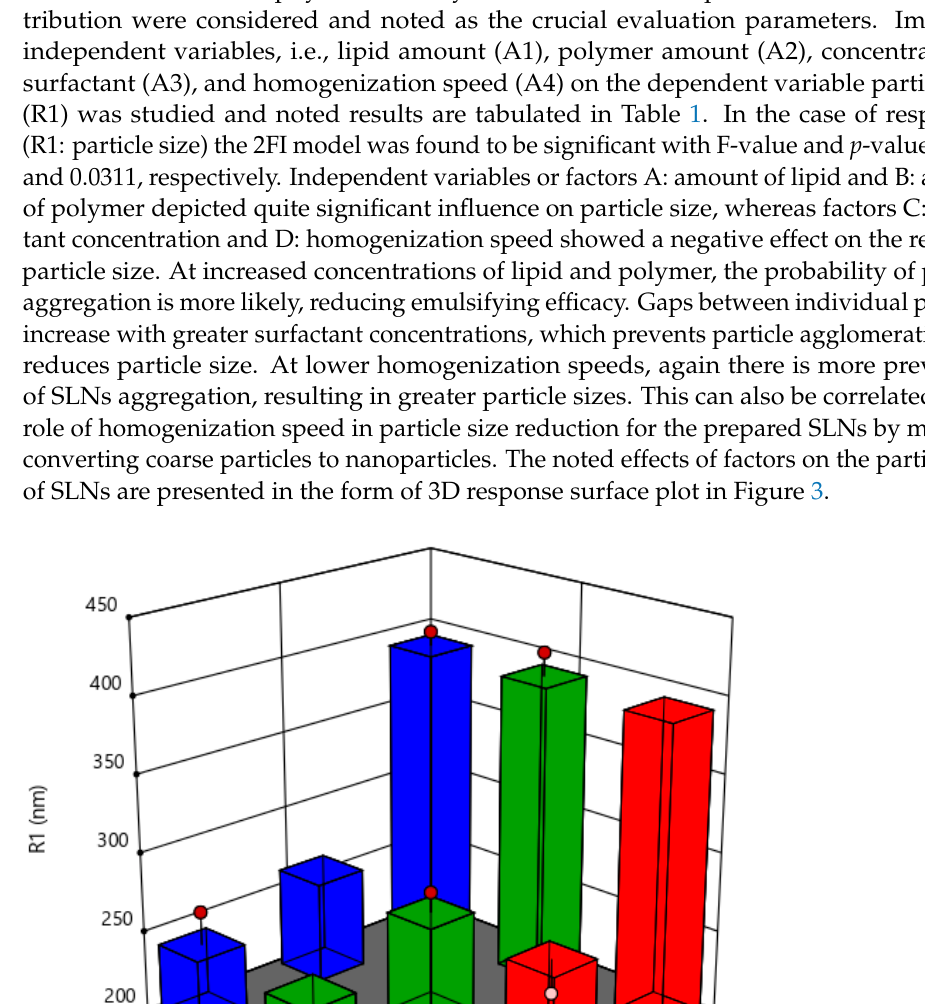
Table 2. Particle size ANOVA Response for 2FI model for the prepared Saxagliptin SLNs.